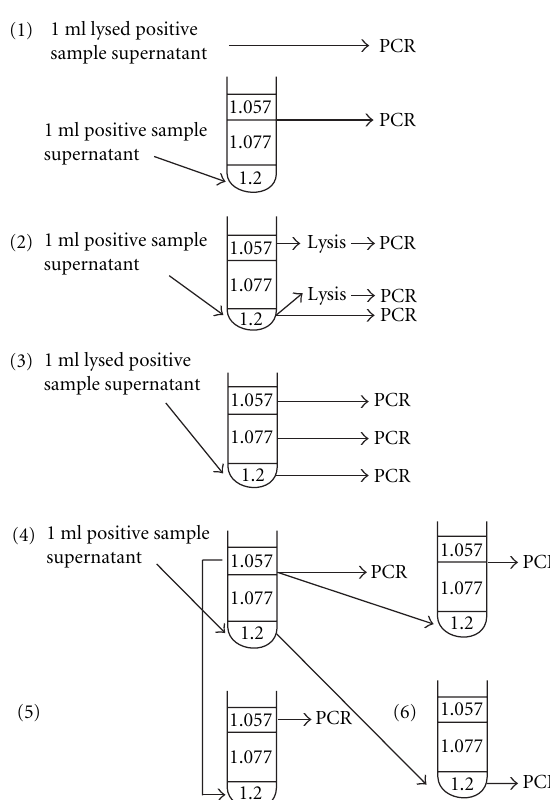
Figure 1: The design of a suitable setup for routine analysis of faecal samples by flotation. Six tubes were prepared and centrifuged in accordance with tube 4, Table 1 (tubes nos. 1 to 6). In tube 1, the sample was prepared by centrifugation and analyzed by PCR. An aliquot of the sample was lysed by boiling and analyzed by PCR without previous centrifugation. In tube 2, the top and the bottom phases were lysed before PCR. An aliquot of the bottom phase was analyzed by PCR without previous lysing. In tube 3, a lysed sample was included and all phases were analyzed by PCR. In tube 4, the upper interphase was subjected to a second centrifugation. Aliquots of the upper interphases from both centrifugations were subjected to PCR and the results were compared. The top and bottom fractions, respectively, from tube 4 were mixed with 1 mL supernatant from a negative faecal sample before centrifugation (tubes 5 and